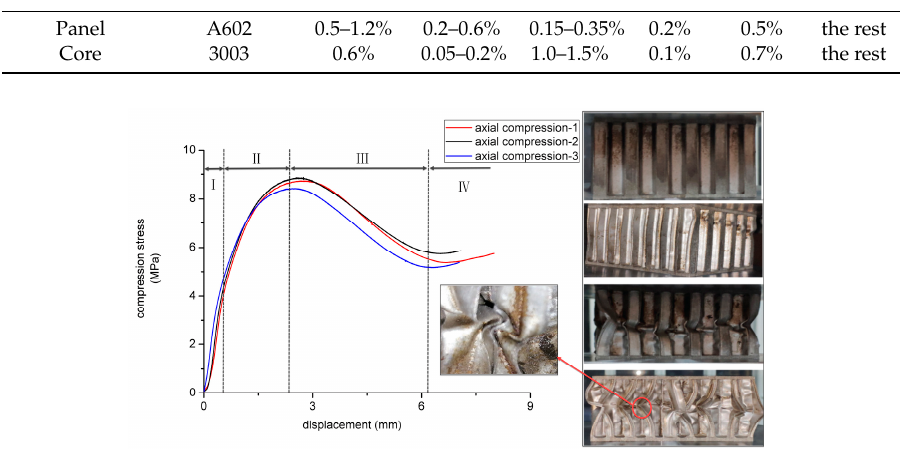
Figure 3. Stress–displacement curves and failure modes of the BAHP.